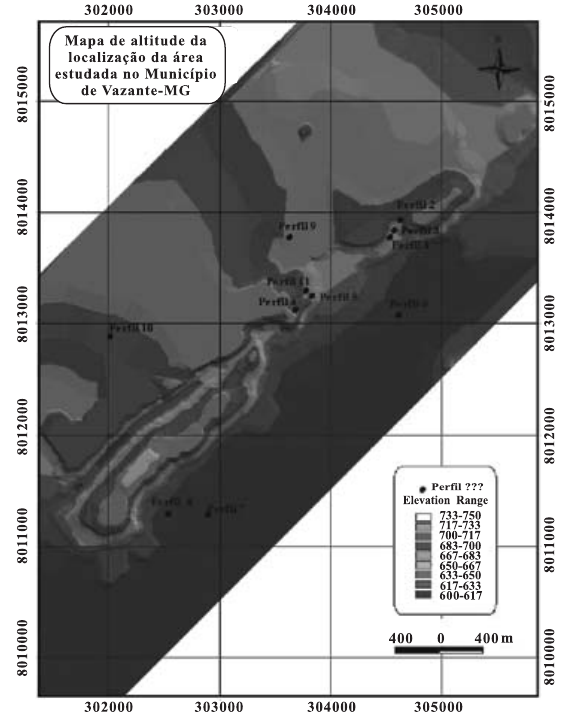
Figura 1. Localização dos perfis coletados com referência de